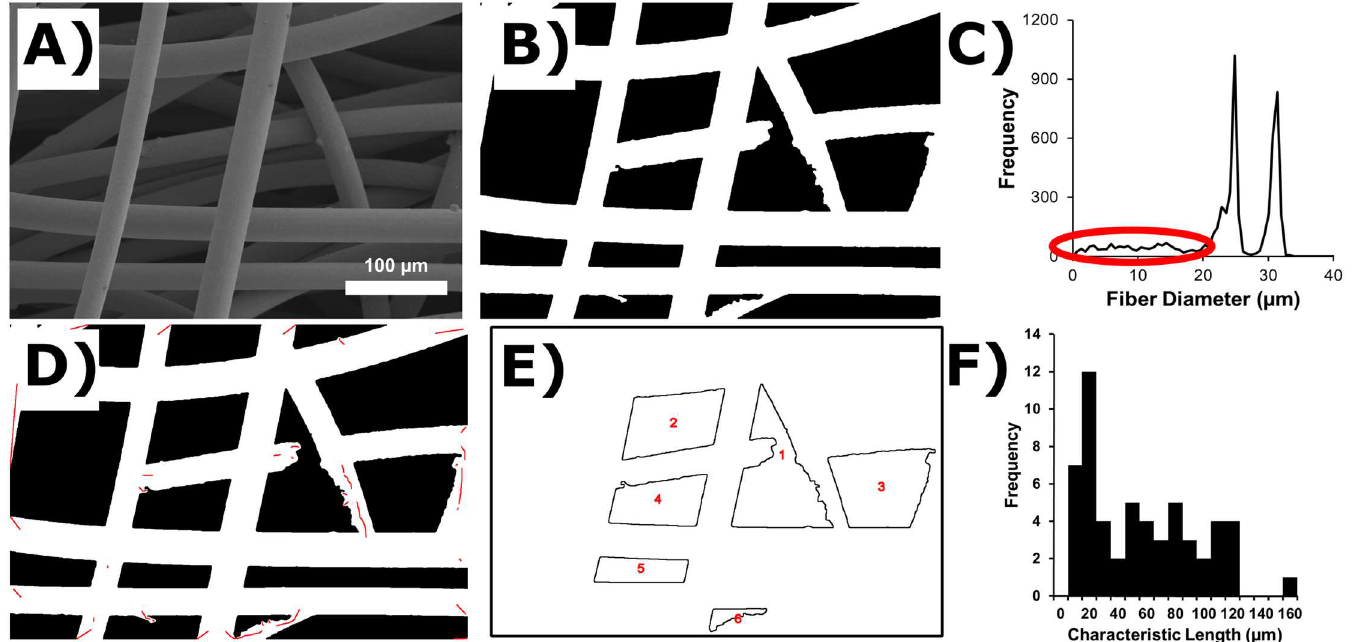
Fig 2. Examples of DiameterJ output. (A) One of the scanningelectron micrographs (SEM) that was used in participant performanceassessment is shown. Two gauges of steel wire were entangledto make the sample for the image: 48 gauge (31.1 μ m dia.) and 50 gauge (25.6 μ m dia.). (B) Segmentation of the SEM image in A. (C) Histogramof all diameters that were calculatedfrom the image by DiameterJ. Red oval indicates“noise”. (D) Red lines indicate location of fiber centerlines that had a dia. between0 and 20 micrometers and that should be considered “noise”. (E) Outlines of pores (pores touchingthe edges of the image have been removed). (F) Histogram of characteristic lengthsbetweenfiber intersections (bin size 10 μ